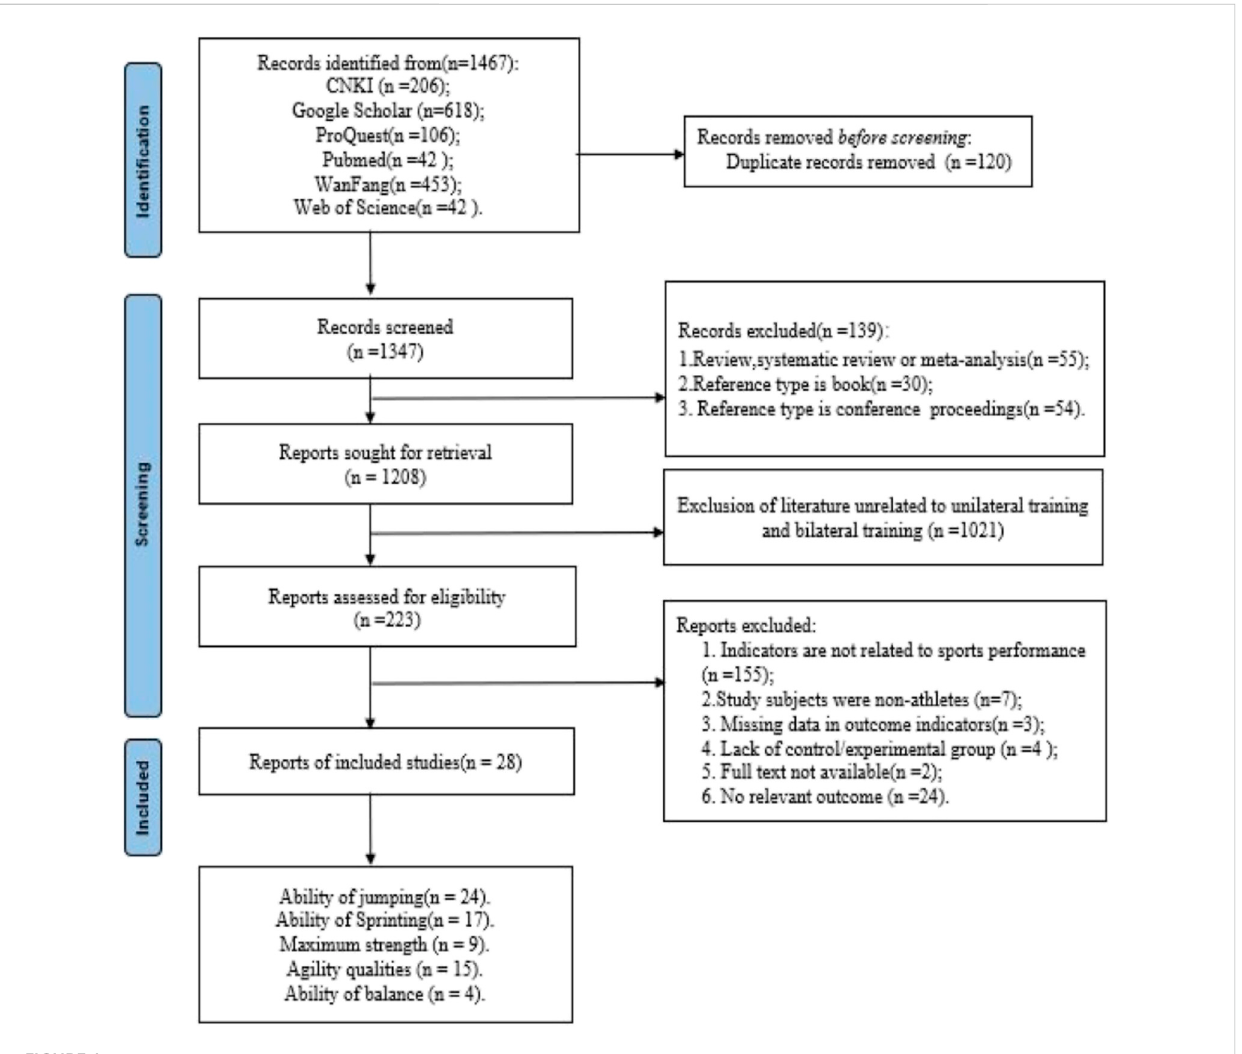
FIGURE 1 Flowchart for inclusion and exclusion of